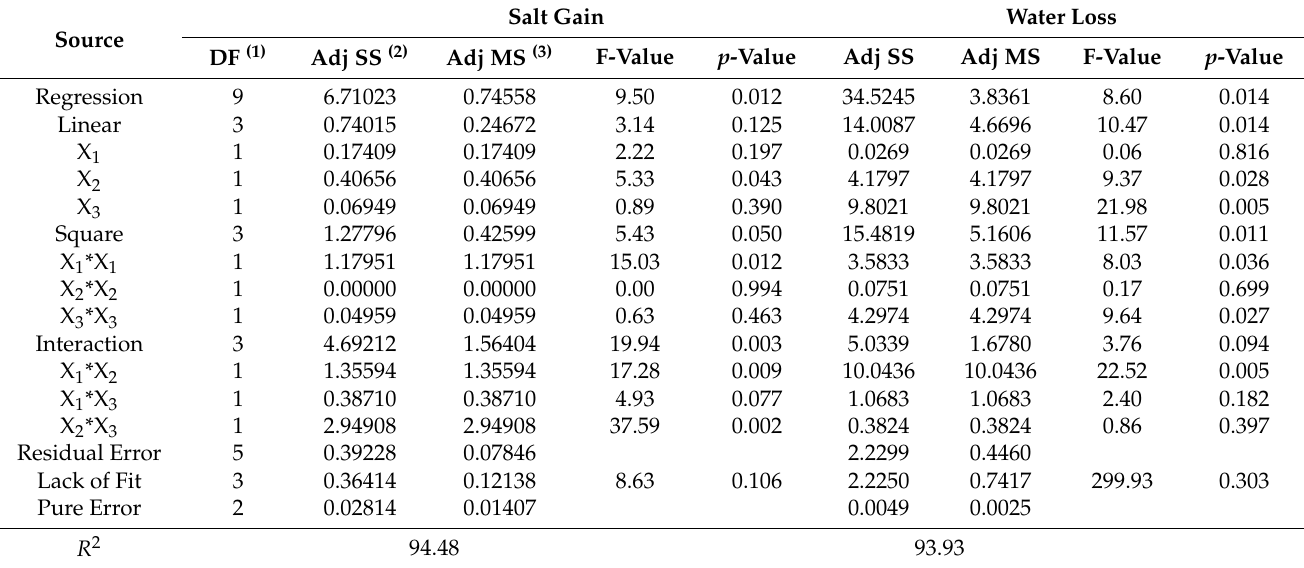
Table 3. Matrix design results for the experiments performed according to the Box–Behnken experimental design for quality values of brined Kimchi